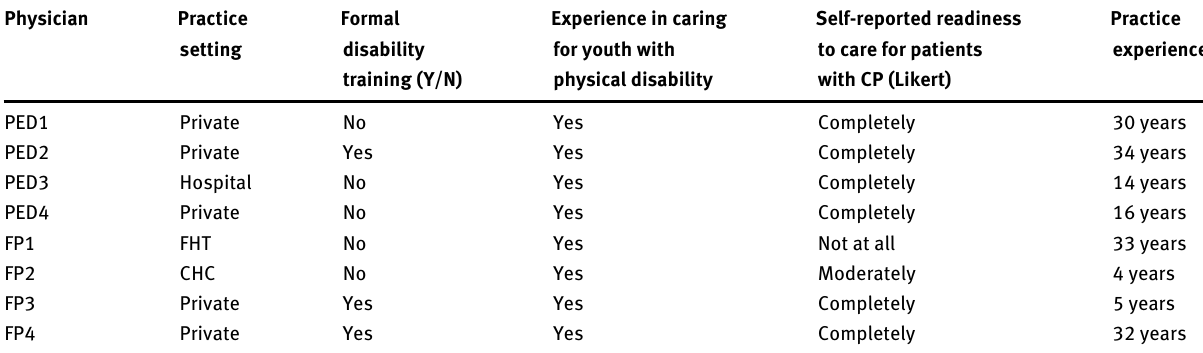
Table 2: Characteristics of